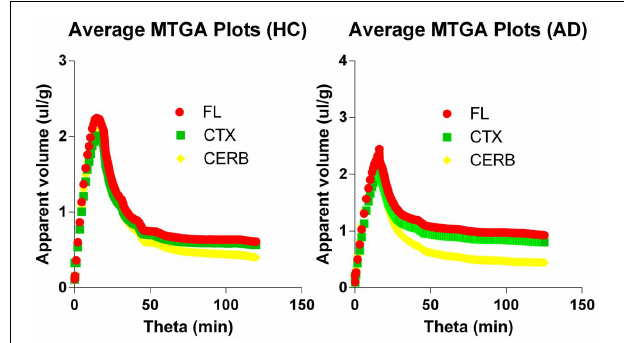
FIGURE 4 | Multitime graphical analysis (MTGA) plots of blood-brain transfer of [ 11 C ] PiB according to Equations (1) and (2). MTGA plots reveal effect of generation of metabolites that do not enter brain tissue and disappearance of [ 11 C ] PiB from circulation, with rapid reduction of apparent volume of distribution [ 11 C ] PiB in brain after 4 minutes of circulation, corresponding to 10min in units of normalized time. Left panel: Healthy volunteers. Right panel: Patients with Alzheimer’s disease. Abscissae: Normalized time (minutes). Ordinates: Apparent volume of distribution (ml/cm 3 ).